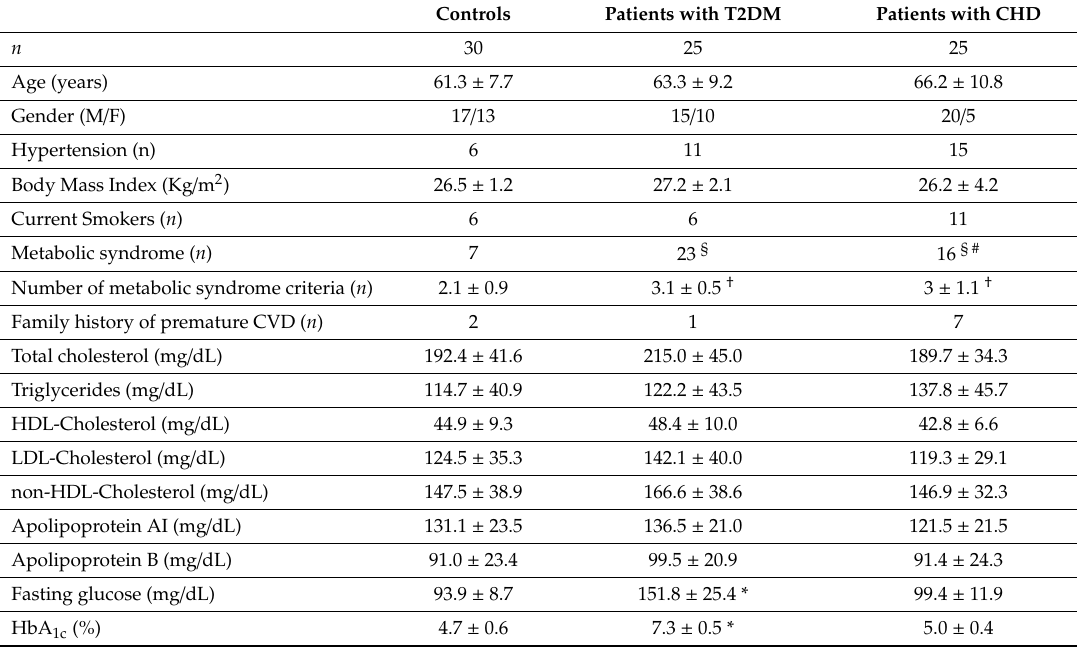
Table 1. Clinical and biochemical characteristics of the study population. Controls Patients with T2DM Patients with